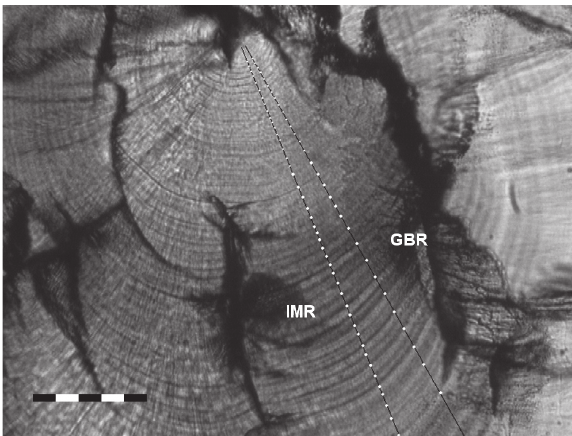
Fig . 2. – Saggital section of an anchovy otolith, showing the prob- lems and reading methods for discriminating daily from sub-daily increments. Core showing the special rhythmic pattern of growth consistent in alternate white and dark bands (Zone I, II and III). GBR represents the growth band reading method, while IMR repre- sents the individual mark reading method (Bar 100 µ